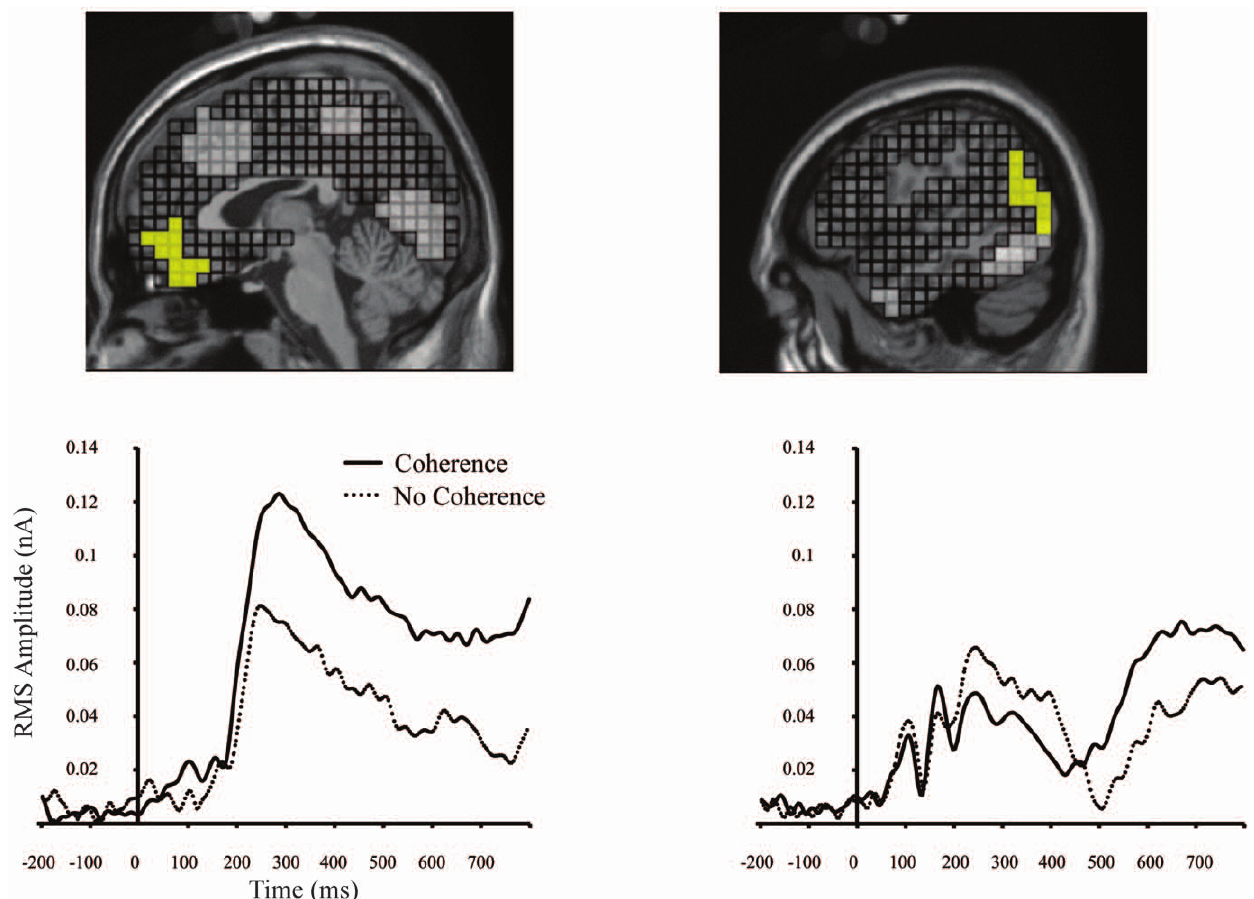
Figure 4. Source locations and source waveforms. Top: Location of OFC and Occipital-Temporal-Parietal ROIs (in yellow). Other ROIs can be seen in these two views (Left: ACC, PCC/Precuneus, and Lingual Gyrus; Right: Inferior Temporal Lobe, and Anterior Temporal Lobe). Bottom: source waveforms of grand-average activity for mOFC (left) and right TPO ROIs.